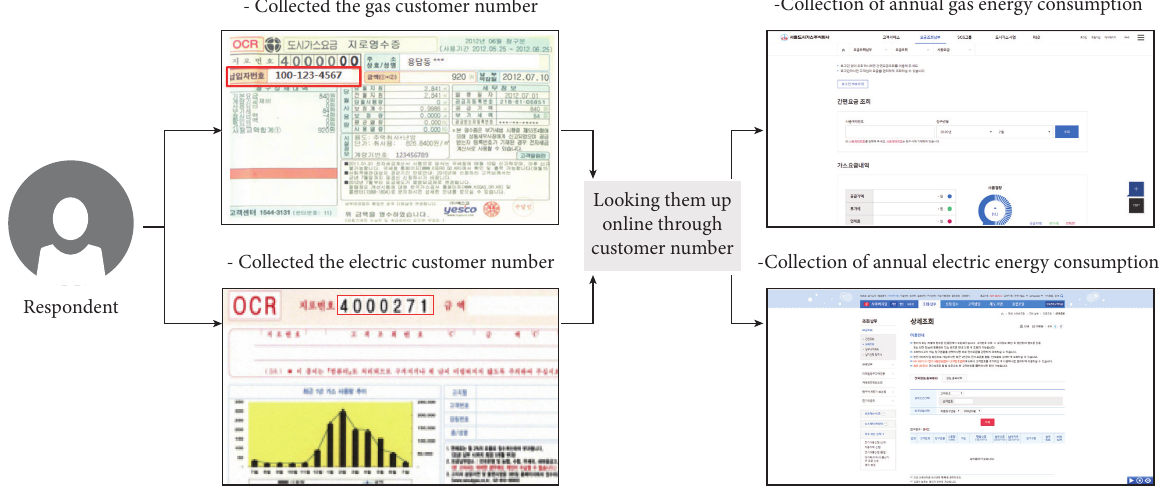
Figure 6: Method for collecting energy